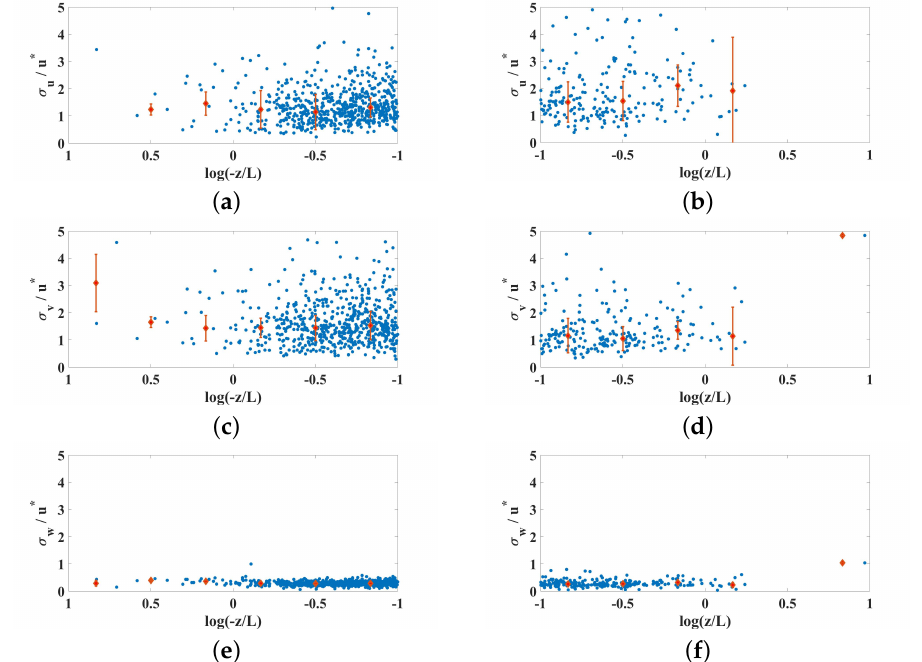
Figure 7. The standard deviation of turbulent velocity fluctuations normalized by friction velocity, σ i / u ∗ , for all months of 2021 ( a , c , e ). Unstable − z/L conditions are on the left, and stable +z/L conditions are on the right ( b , d , f